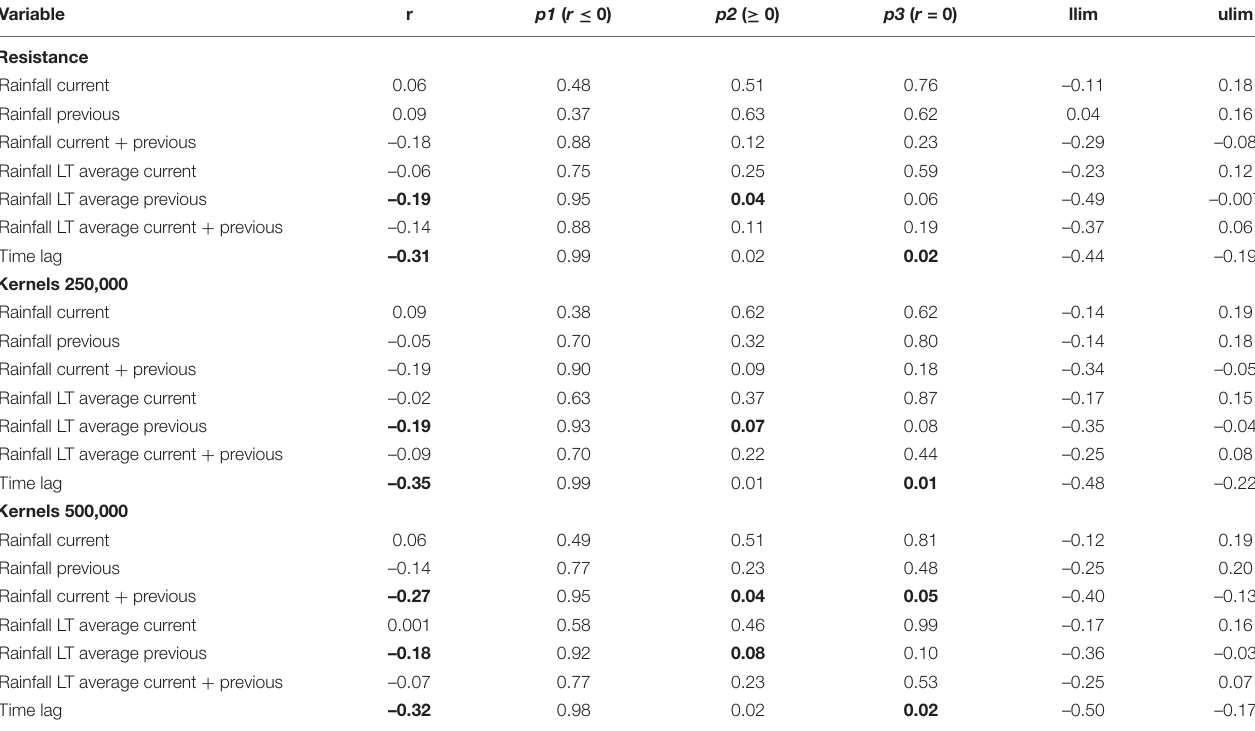
TABLE 3 | Mantel test between correlation of monthly resistances/cumulative resistance kernels and difference in rainfall across months (current month, previous month, current plus previous month, long-term average for a month, long-term average for a previous month and long- term average for current plus previous month) and time lag between